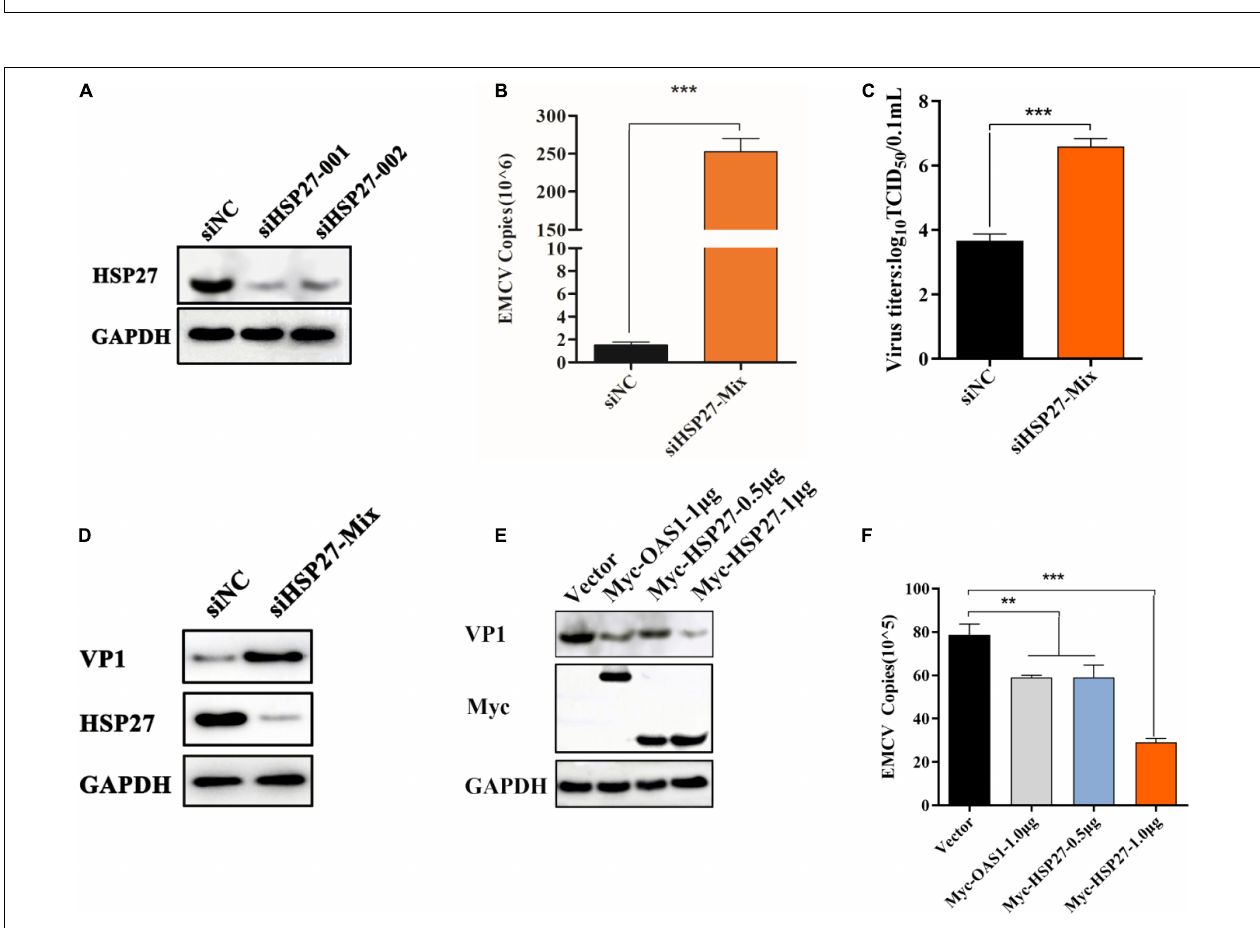
FIGURE 4 | HSP27 has an antiviral role against encephalomyocarditis virus (EMCV). (A) A549 cells in 6-well plates cells were transfected with either 150 nmol of siHSP27-001, siHSP27-002, or siNC for 36 h before measuring HSP27 protein by immunoblotting. GAPDH was used as a loading control. A549 cells were transfected with either 150 nmol of siHSP27-Mix or siNC for 36 h before infecting with EMCV at an multiplicity of infection (MOI) of 0.01 for 36 h. (B) EMCV copy number was quantified by RT-qPCR, and (C) Viral titers were measured by TCID 50 assay. (D) The protein expression of HSP27 and VP1 were analyzed by immunoblotting. GAPDH was used as a loading control. A549 cells were transfected with pCMV-Myc (1 µ g), Myc-OAS1 (1 µ g), or Myc-HSP27 (0.5/1 µ g) plasmids for 24 h before infecting with EMCV at an MOI of 0.01 for 36 h. (E) The protein expression of Myc tag and VP1 were analyzed by immunoblotting. GAPDH was used as a loading control. (F) Cells and supernatant were harvested, and EMCV copy number was measured by RT-qPCR. Data were represented as mean ± SD of three independent experiments and were measured in technical duplicate, ** P < 0.01 and *** P < 0.001.